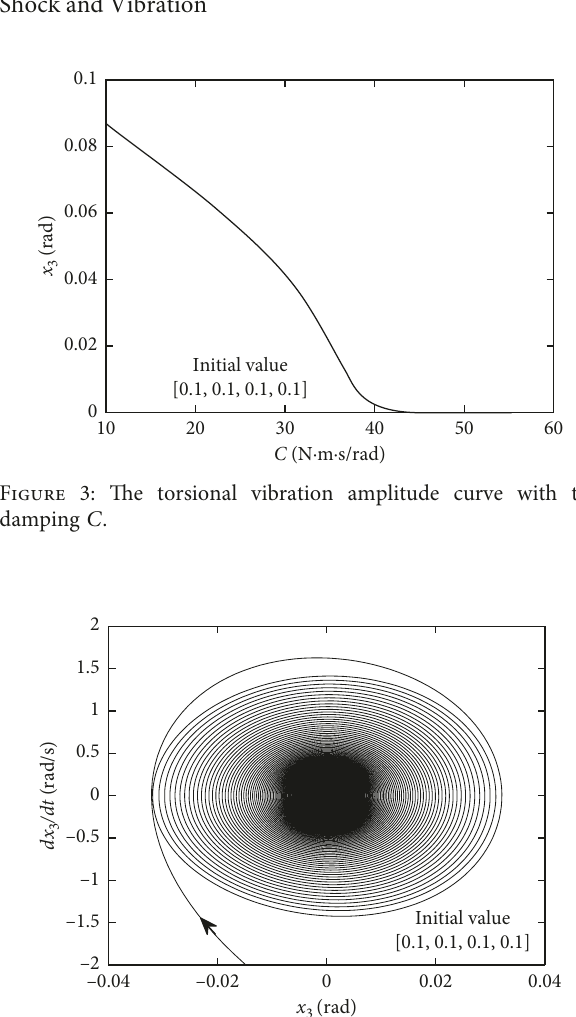
Figure 4: The time history of the system at C �